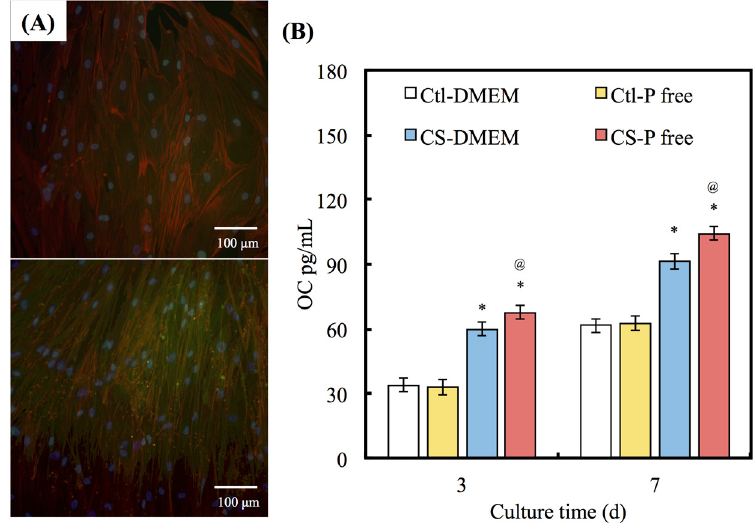
Figure 7. ( A ) Immunofluorescence images and ( B ) protein of OC expression of hDPCs cultured on CS with two DMEM for 7 days. (Nuclei: blue, F-actin: red and OC: